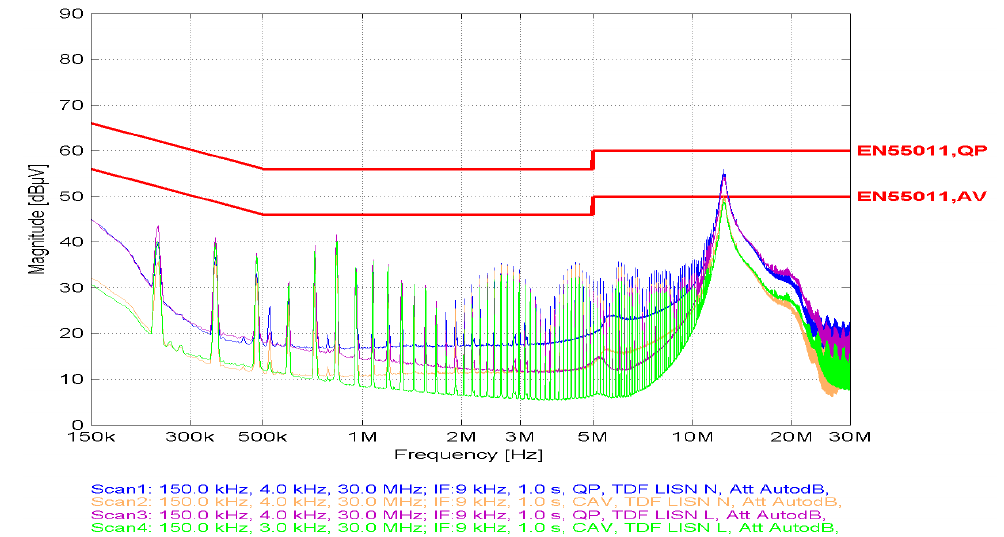
Figure 6. Attenuation level for ferrite No. 1 with the basic number of coils (22